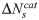
Contribution of individual categories (ΔNscat) towards food pairing bias and its statistical significance.Randomizing ingredients within a certain category provides an insight into their contribution towards bias in food pairing. Spice and dairy category showed up as prominent categories contributing to the negative food pairing of regional cuisines.